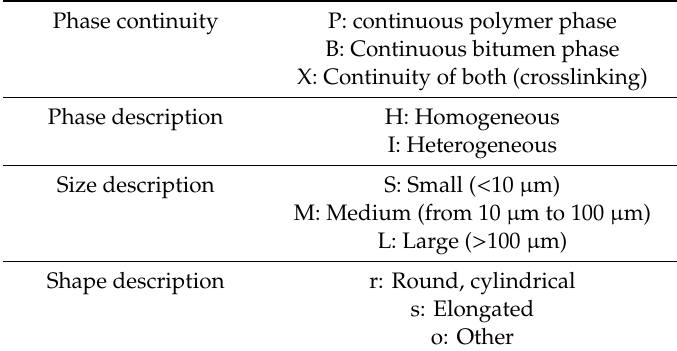
Table 5. Letter coding description according to